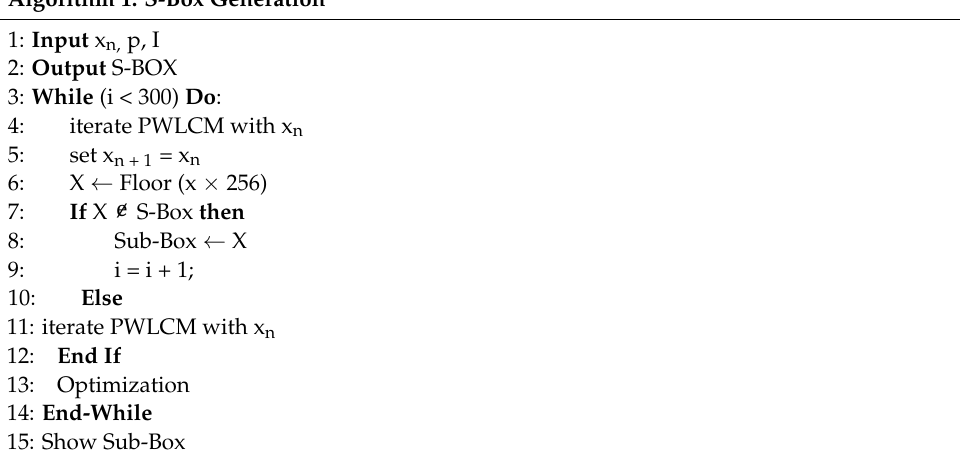
Algorithm 1: S ‐ Box Generation Algorithm 1: S-Box Generation